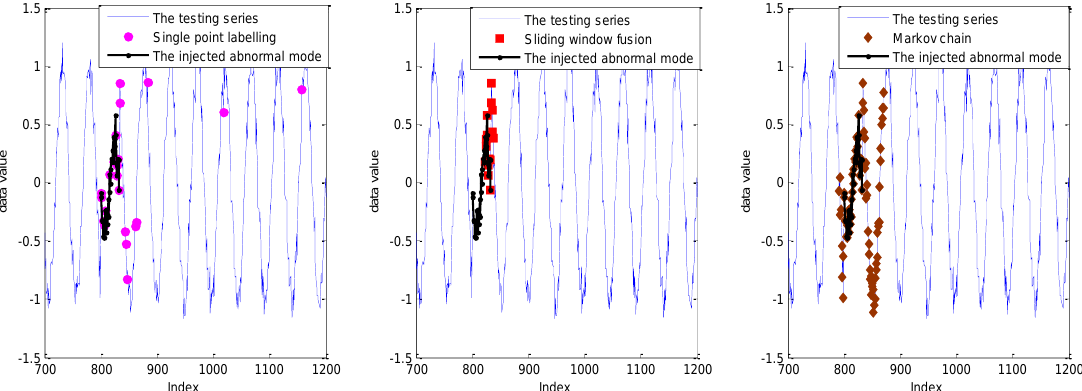
Figure 7. The detection results for the Keogh Data with three labelling strategies under the sliding window size of 10.